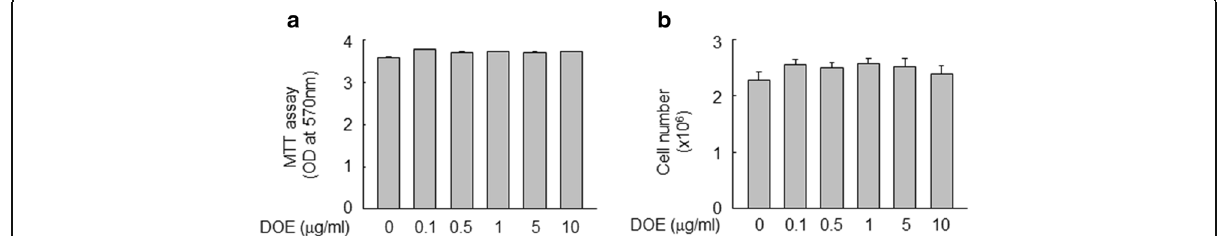
Fig. 1 Cell viability was not affected by the concentrations of DOE tested. RAW 264.7 cells were treated with the indicated concentrations of DOE. After incubation for 24 h, cell viability was assessed by the MTT assay ( a ) or the trypan blue exclusion method ( b ). The results are plotted as the means ± S.E. ( n = 4)